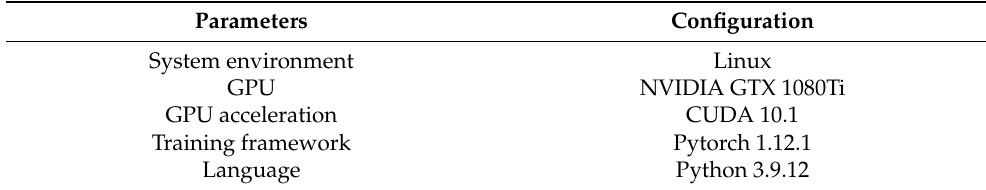
Table 4. The configuration of the